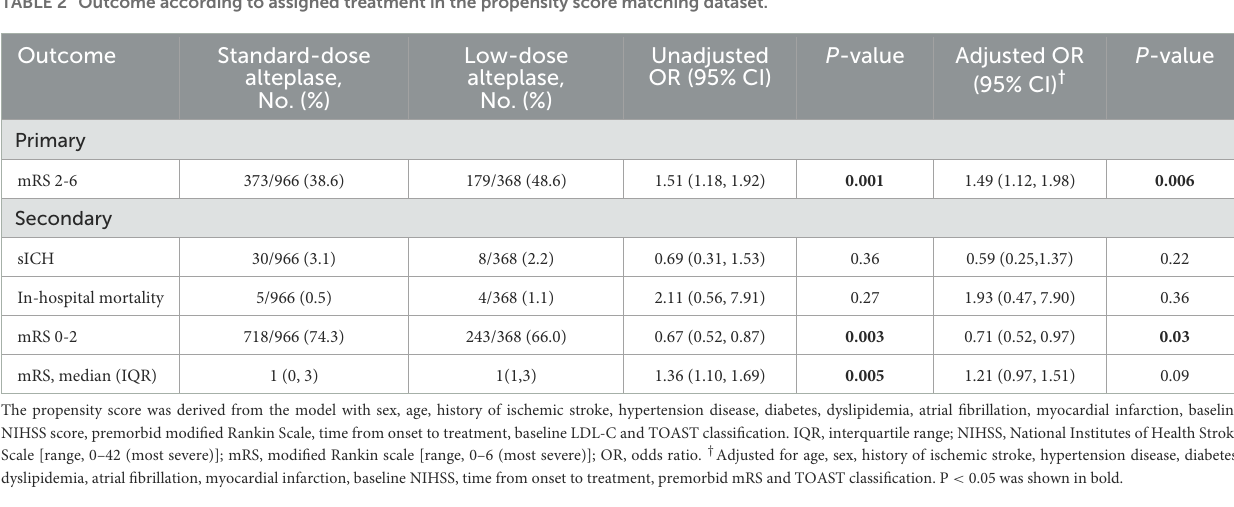
TABLE 2 Outcome according to assigned treatment in the propensity score matching dataset.